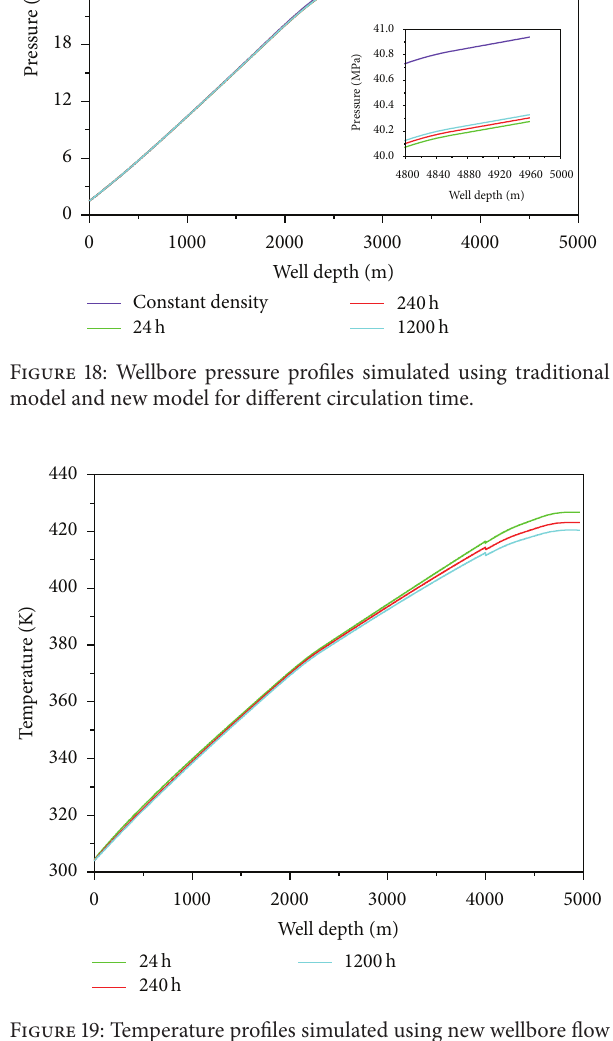
Figure 19: Temperature profiles simulated using new wellbore flow model for different circulation